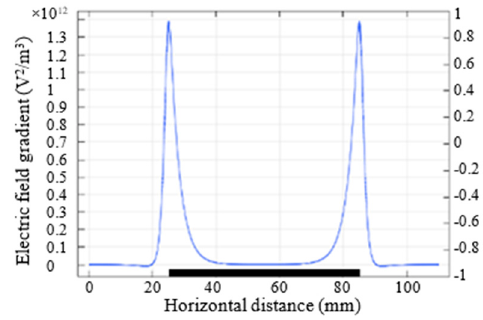
Figure 4. The electric field gradient in geometry.